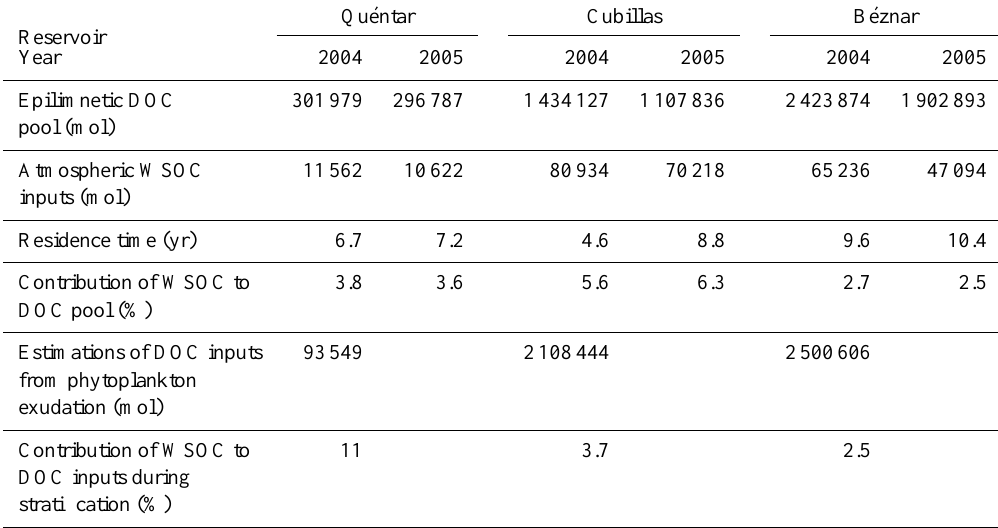
Table 6. Contributions of water-soluble organic carbon (WSOC) inputs to mean dissolved organic carbon (DOC) pool into the epilimnion of the three study reservoirs and to the total DOC inputs (atmospheric + phytoplankton exudation) during the stratification period.